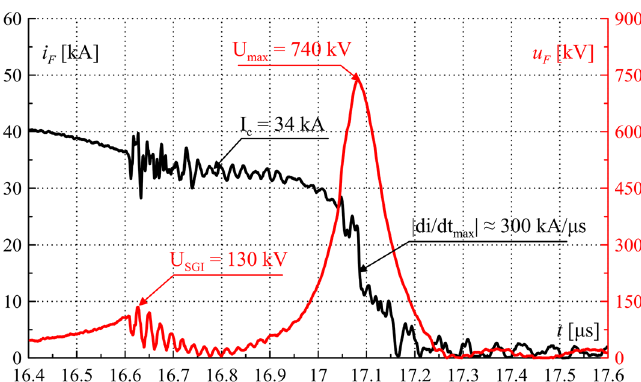
Figure 15. TSFF current i F and voltage u F waveforms during operation—laboratory test results. Characteristic values are marked in the figure. Close-up on the commutation and the current limiting